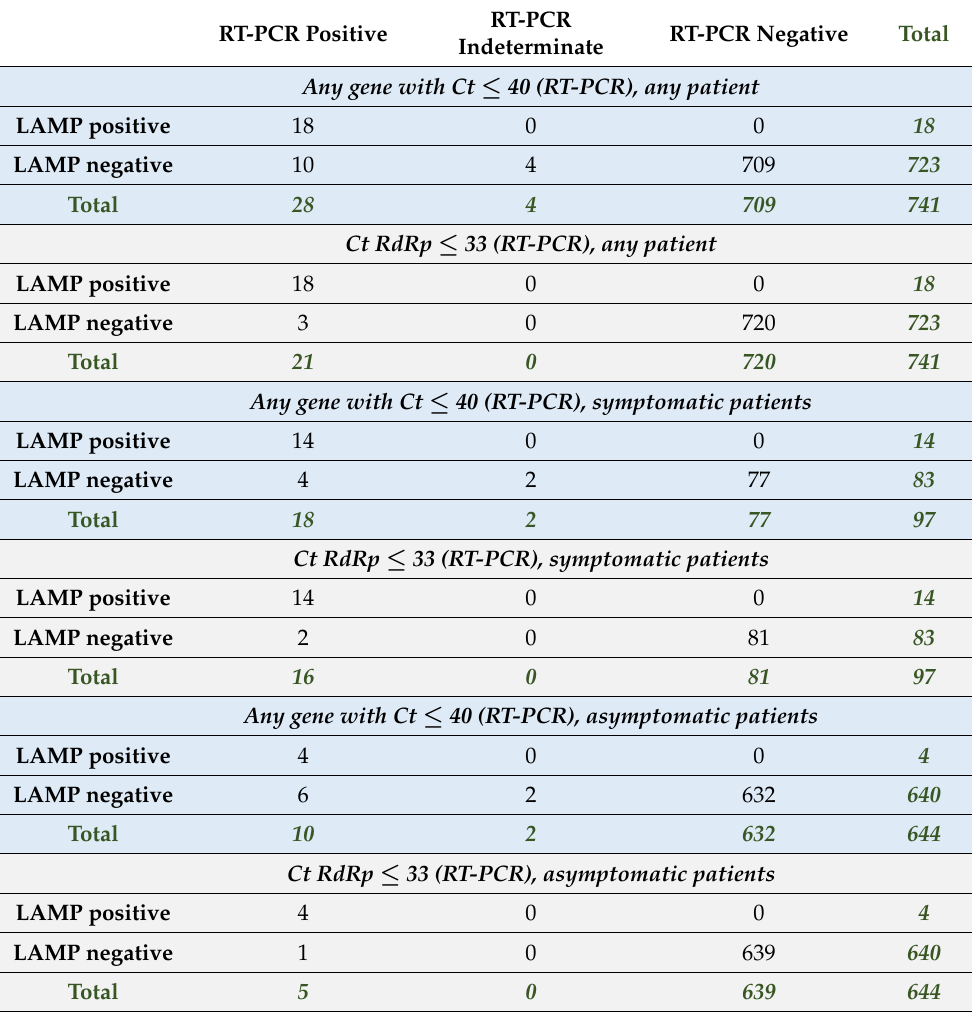
Table 1. RT-PCR and RT-LAMP results for different definitions of